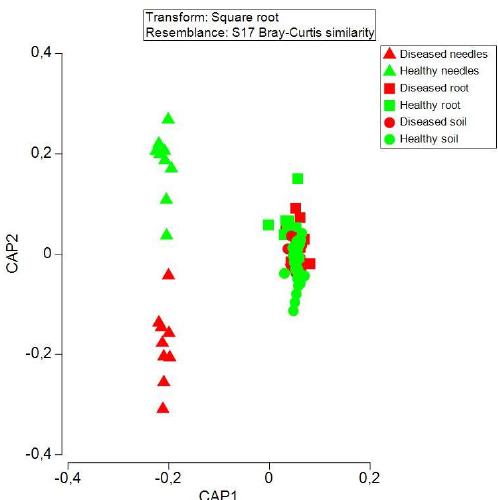
Figure 6. Canonical correspondence analysis (CCA) showing the bacterial functional structure in healthy and diseased samples in the needles, roots, and soil.